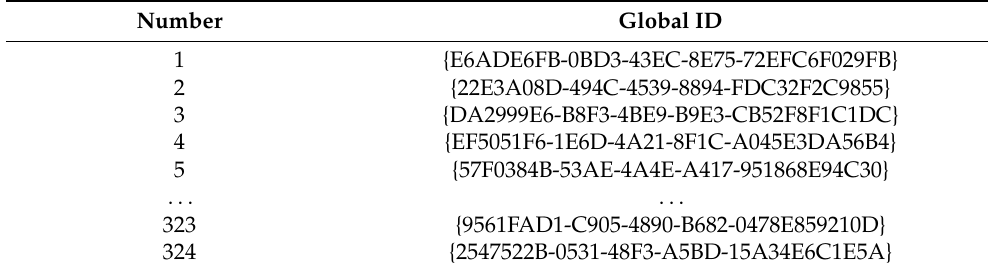
Table 3. New report records of Asian giant hornets.